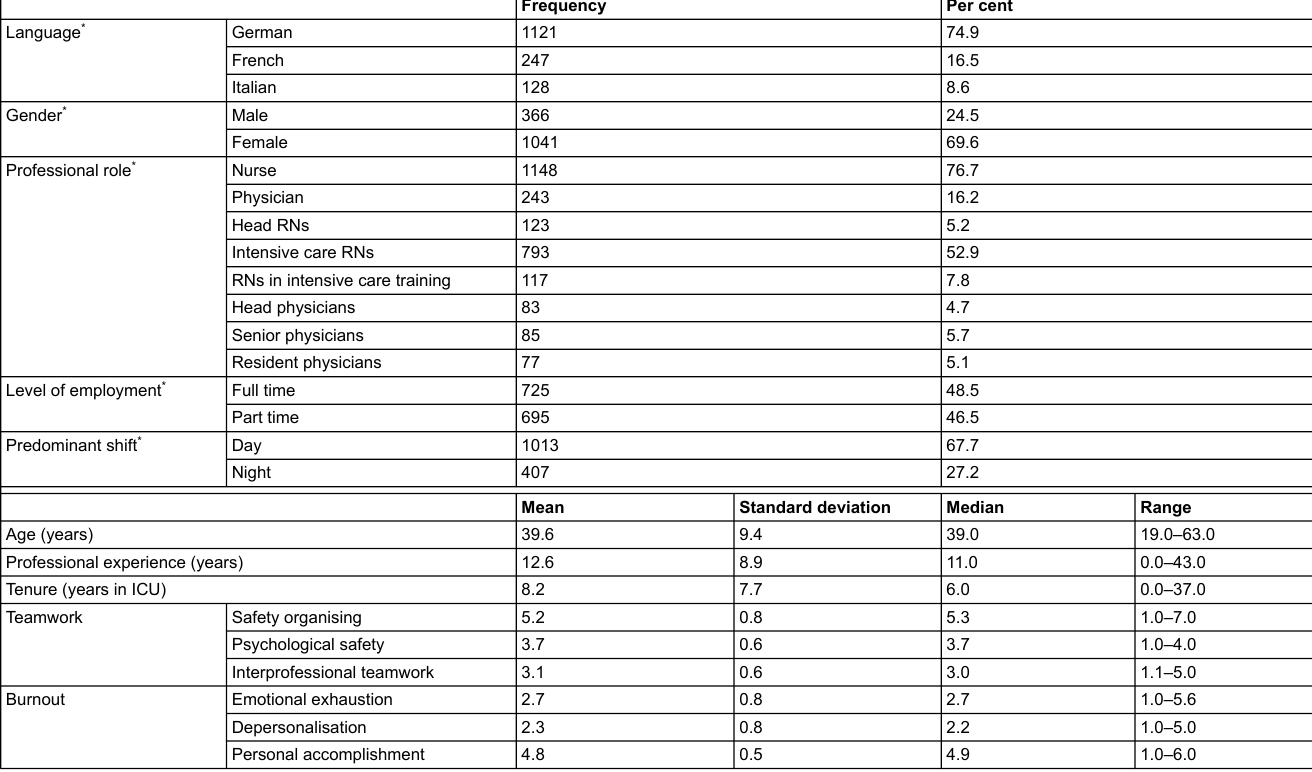
Table 2: Descriptive statistics of survey participants (n = 1496) .